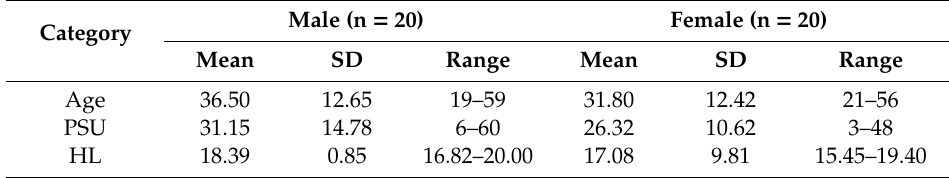
Table 1. Participants characteristic for the experiment.